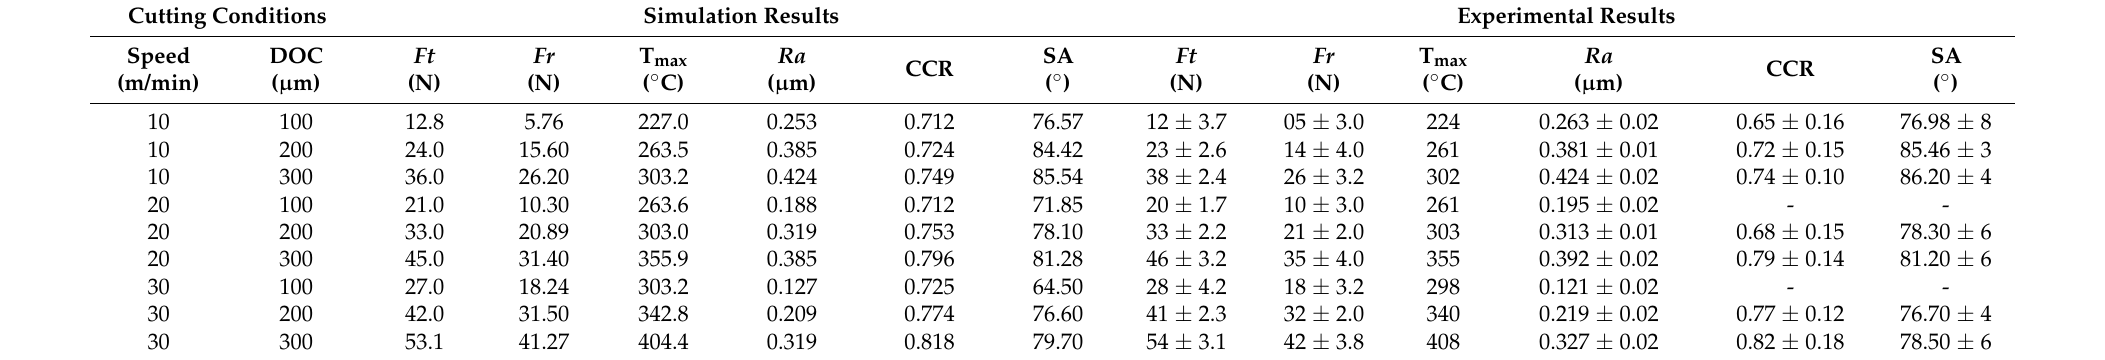
Table 7. Comparative analysis of experimental and simulation results in